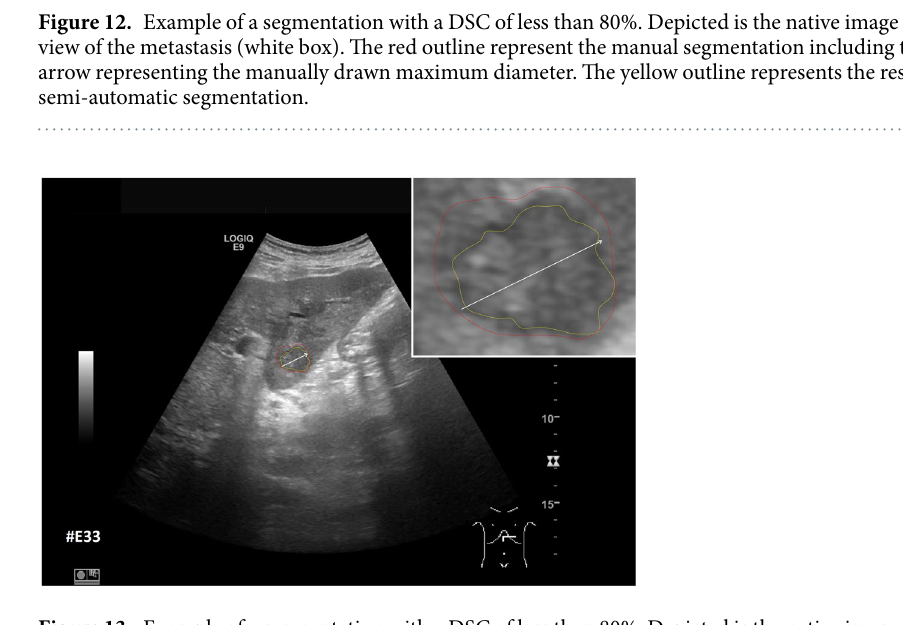
manual segmentation including the white arrow representing the manually drawn maximum diameter. The yel- low line represents the result of the semi-automatic segmentation (see also Fig. 10). Compared with the manual segmentation, our semi-automatic segmentation algorithm could achieve a DSC of 92.47%. However, compared with the manual segmentation, the GrowCut-based segmentation achieved a DSC of 85.46%. Finally, Table 2 pre- sents a direct comparison for the four cases where our approach could achieve a DSC higher than 90% and the six cases where our approach achieved a DSC lower than 80%. For the RSS, several parameters had to be defined: The Approximate Volume, the Intensity Homogeneity, the Boundary Smoothness and the Max running time (min).